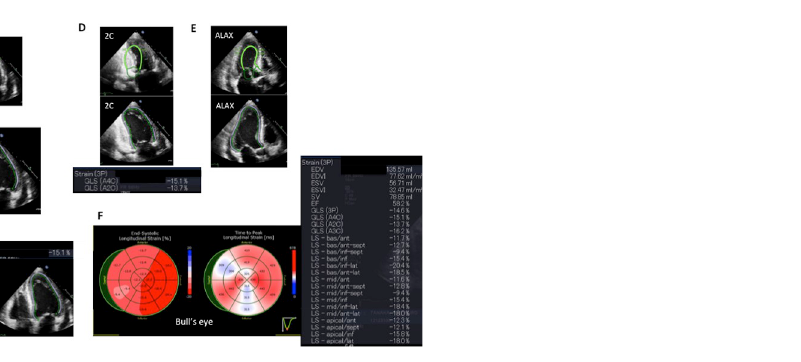
Fig 1. Step-by step approach to left ventricular (LV) volume and function measurements. A: Manual registration of apical 4-chamber view at end-diastole. B: Automatic LV endocardial border tracing (green line) at end-diastole in apical 4-chamber view. C: 2D speckle tracking analysis throughout the cardiac cycle, and a GLS of 4-chamber view was determined. D: The same procedures on apical 2-chamber view. E: The same procedures on long-axis view. F: Displayed bull’s eye, LV volumes, LV ejection fraction (EF) and global longitudinal strain (GLS).